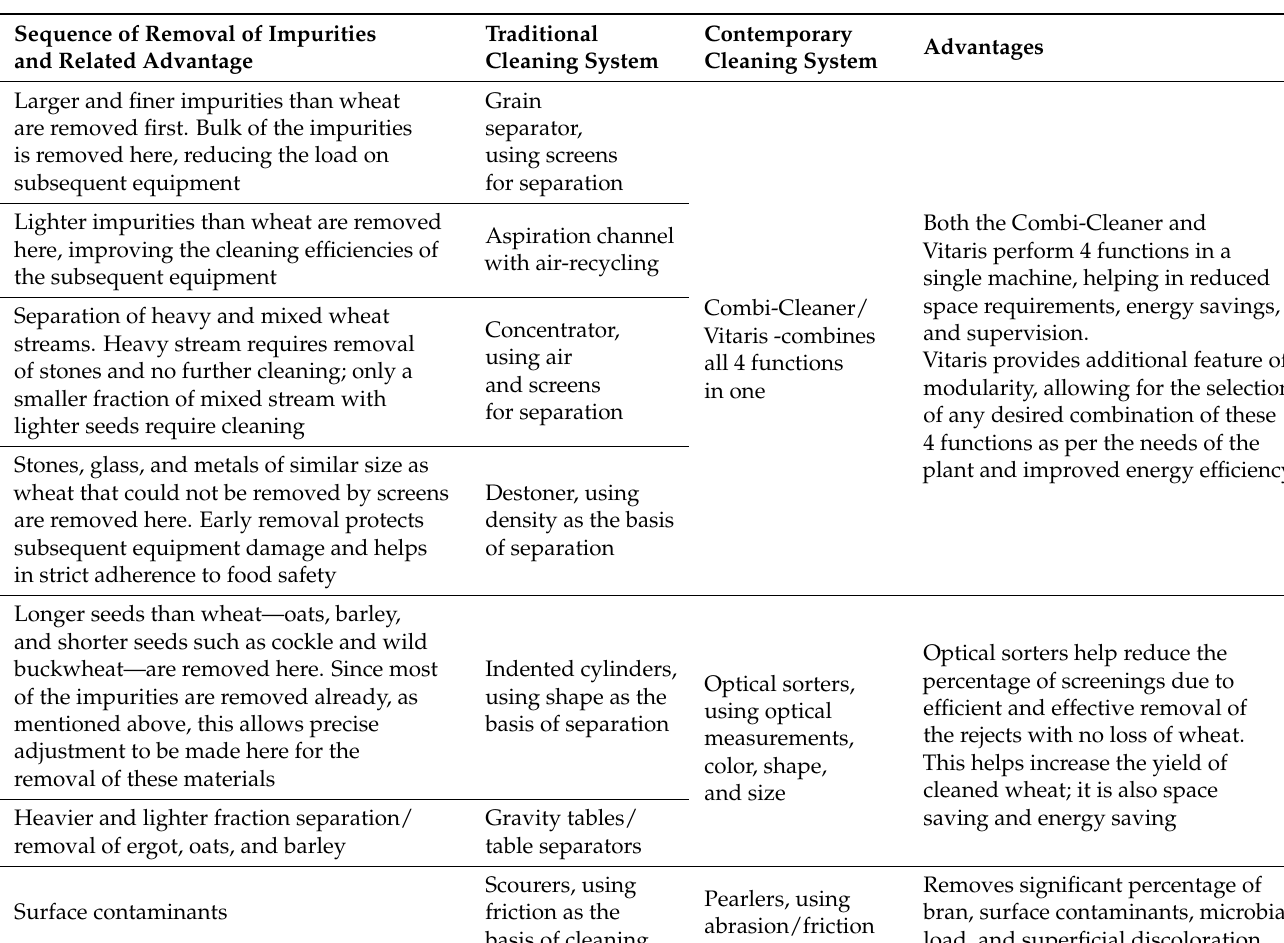
Table 3. Comparative development of cleaning equipment of